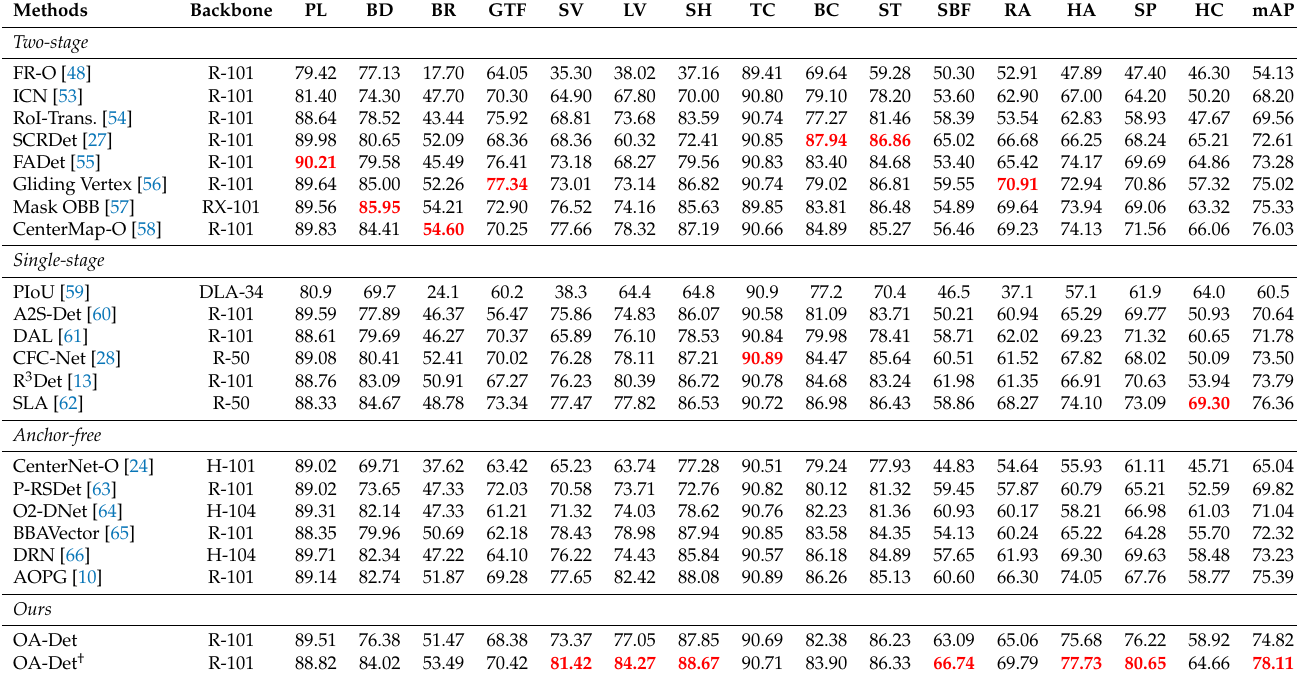
Table 7. Comparisons with other state-of-the-art methods on DOTA dataset. The data in each column indicate the average precision of each category in percent. The last column indicates the mean-Average-Precision of the method: ’†’ represents the results for multi-scale training and testing. The results with red color denote the best results in each